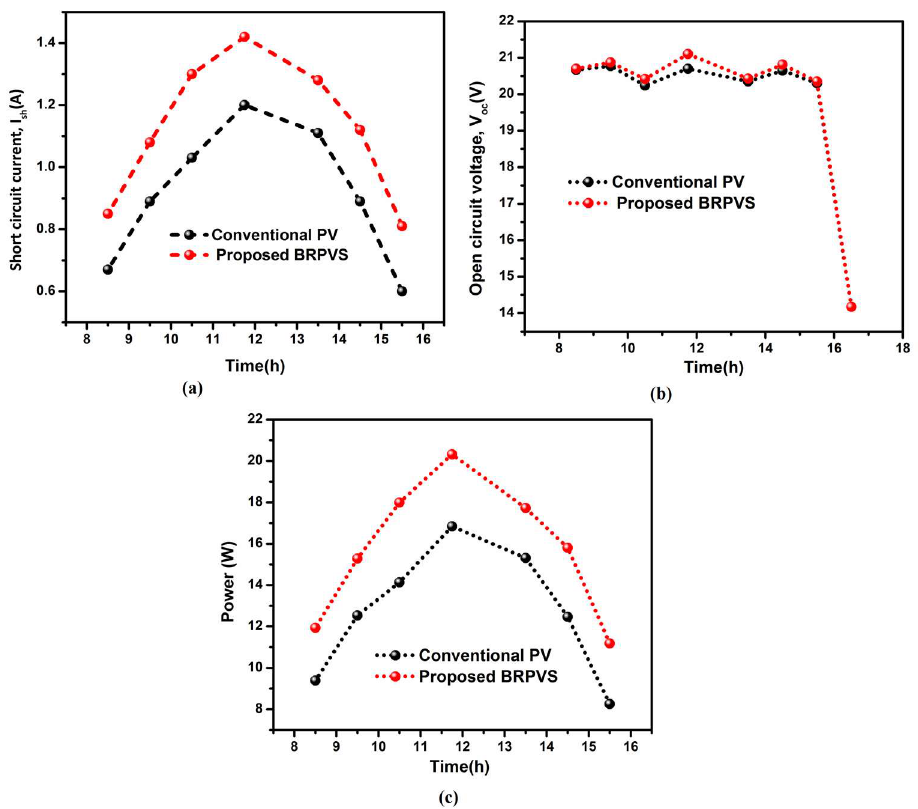
Figure 12. Comparative analysis of the ( a ) Short circuit current (Ish); ( b ) Open circuit voltage (V oc ); ( c ) Output power of BIPV system with and without Al foil based BRPVS.